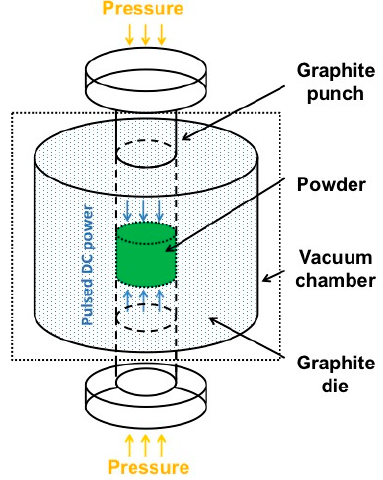
Figure 15. Scheme of the Spark Plasma Sintering.